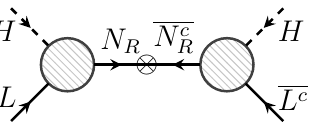
Figure 5 . Radiative seesaw Type-I mechanism for neutrinos [21]. The blob denotes the Dirac mass term generated at two-loop level through the diagram in (cid:12)gure 4. The symbol Majorana mass for N R softly-breaking the Z 4 . Generation indices are suppressed for